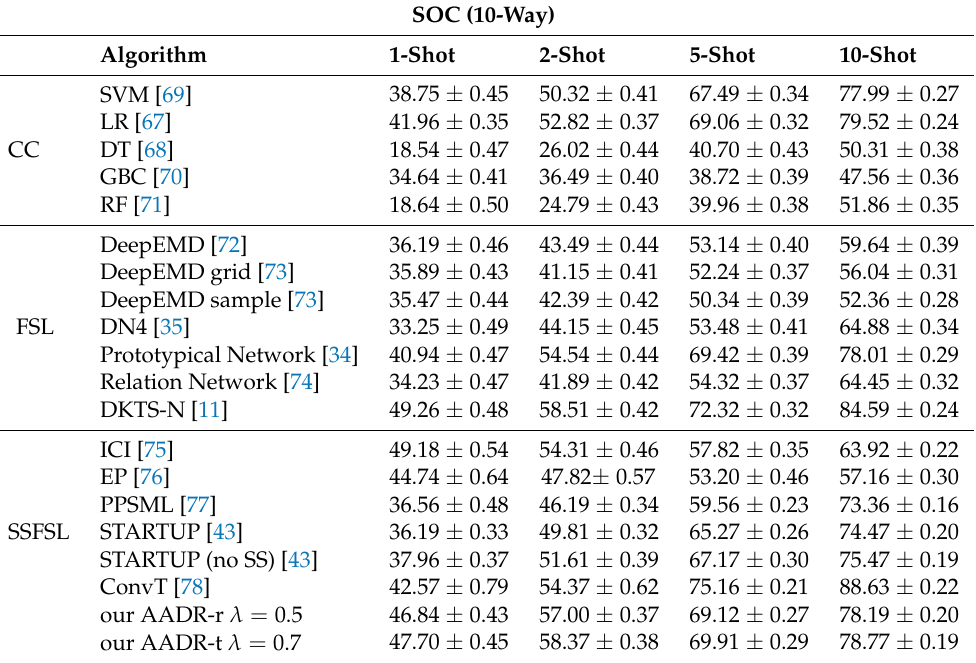
Table 3. Few-shot classification accuracy of SOC among CC, FSL and SSFSL algorithms.